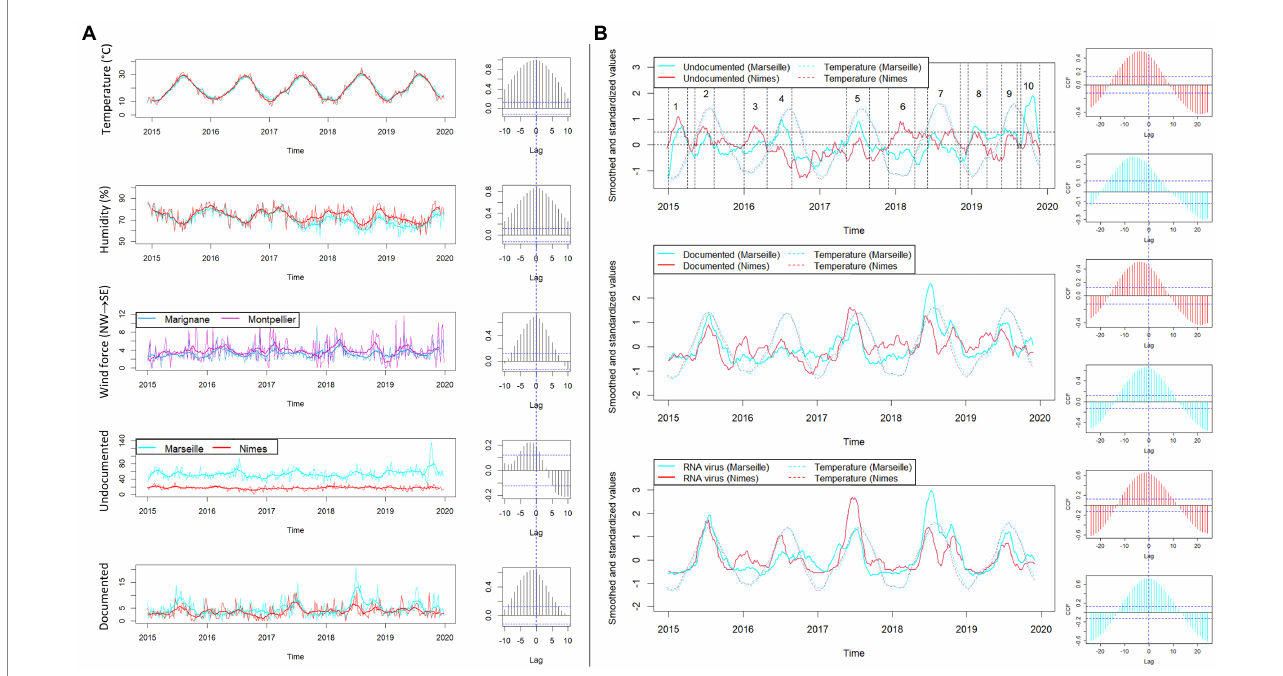
FIGURE 4 Synchronization of outbreaks and weather data between Marseille and Nîmes by time series analysis. (A) The time series for temperatures, humidity, and wind force (in Marignane and Montpellier, two cities close to Marseille and Nimes), undocumented and documented cases are represented for both Marseille (in blue) and Nimes (in red). Each time series is represented in its real values (thin lines) and smoothed with moving average using a window size of 9 weeks (thick lines). To the right of each time series graphic, the associated cross-correlation function plot comparing Nîmes and Marseille at different lags is shown. A high correlation at a negative lag should be interpreted as an event occurring first in Nîmes and then in Marseille. (B) Time series were first smoothed using moving average with a window size of 9 weeks. Then, in order to make the cities and different variables more comparable, a standardization was applied (cantering and scaling). The 10 periods of the outbreaks were defined based on undocumented cases (graphic on the top). The standardized and smoothed time series of undocumented cases, documented cases and specifically RNA virus cases are shown in the three graphics (thick red and blue lines) along with standardized and smoothed temperatures in Nîmes and Marseille (red and blue thin dotted lines). To the right each time series graphic, the associated cross-correlation function plot comparing temperature and undocumented, documented and RNA virus, respectively (from top to bottom), are shown in red for Nîmes and in blue for